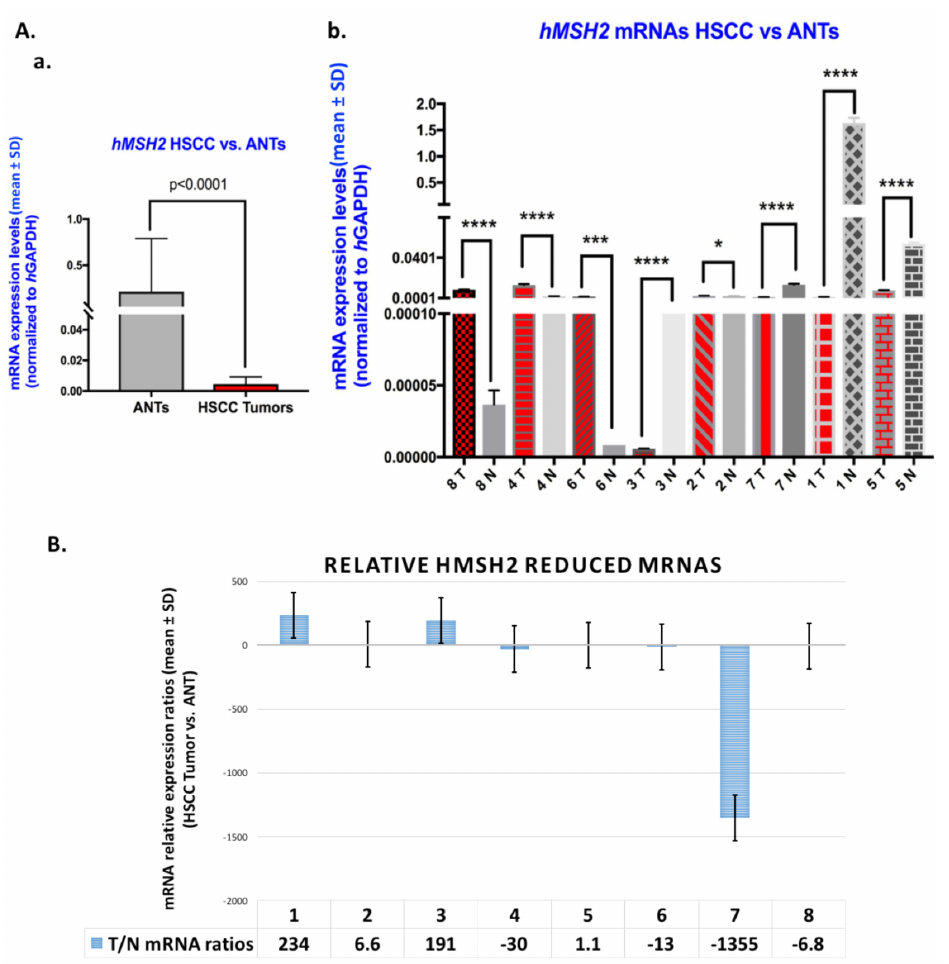
Figure 5. Downregulation of the hMSH2 gene in human HSCC from tobacco smokers. ( A ). Graphs depict mRNA levels of hMSH2 (mean ± SD) were normalized to hGAPDH; by real-time qPCR analysis) for ( a ) total and ( b ) each of the analyzed human HSCC excised from tobacco smokers compared to corresponding adjacent normal tissue (ANTs). (by t test; *, p < 0.05; ***, p < 0.0005; ****, p < 0.00005; multiple comparisons by Holm-Sidak; GraphPad Prism 7.0; data obtained from at least three repetitions). ( B ). Graph depicts the mRNA ratios of hMSH2 gene in HSCC from smokers compared to ANTs (normalized mRNAs to hGAPDH reference